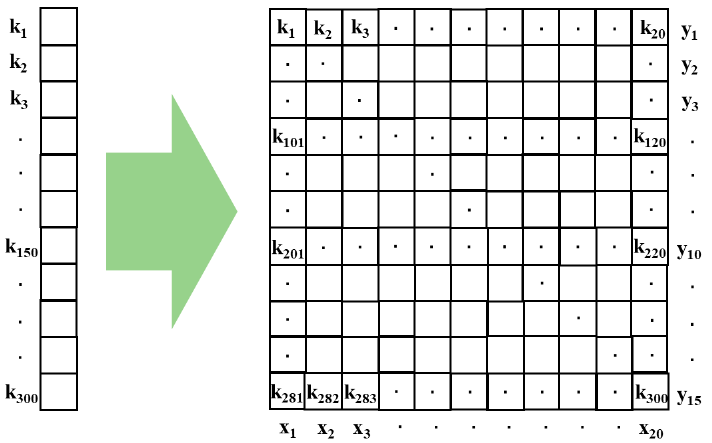
Figure 9. A schematic diagram for the conversion of characteristic lines of mineral pigments from one dimension to two dimensions, where k i represents the normalized intensity value of each characteristic line.